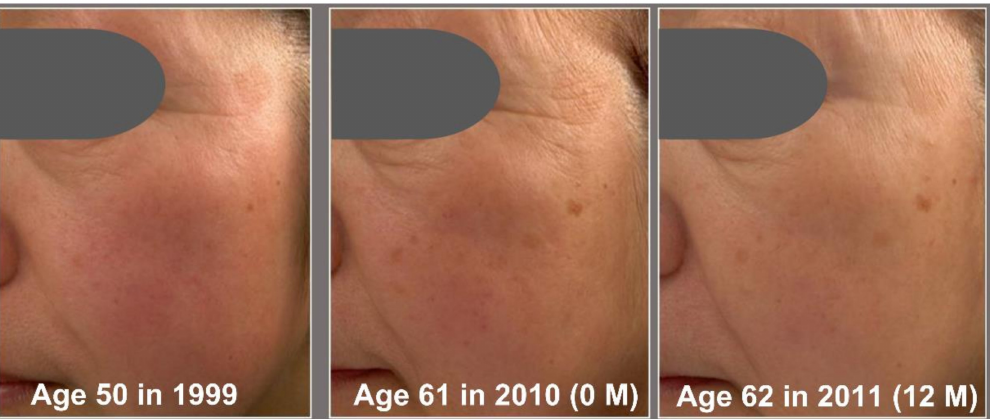
Figure 7. Chronological facial images of Case 2 (age: 50 in 1999). Twice-daily application of G3 products was performed from 2010 (0 M) to 2010 (12 M). Visual facial appearance aged from 1999 to 2010 (0 M), but it was rejuvenated in 2010 (12 M) to close to the level in 1999.